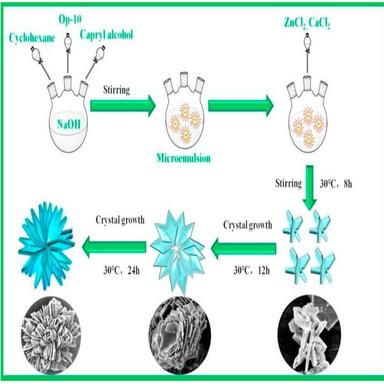
Schematic illustration of the synthesis process of the 3D flower-like calcium zincate.